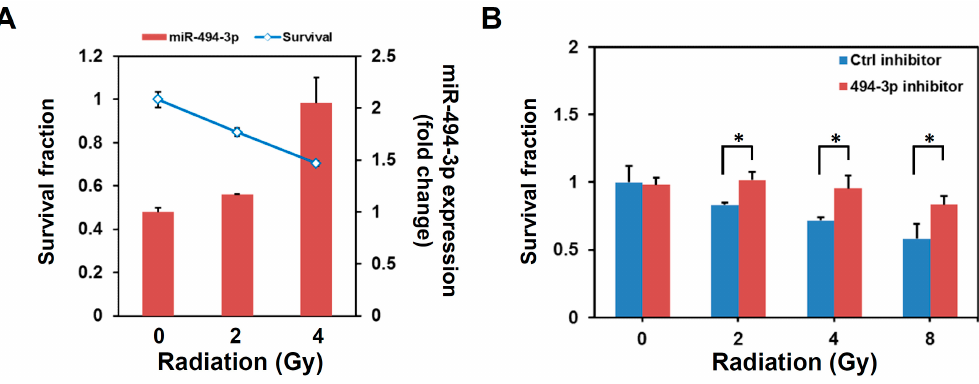
Figure 1. Cont. Figure 1.